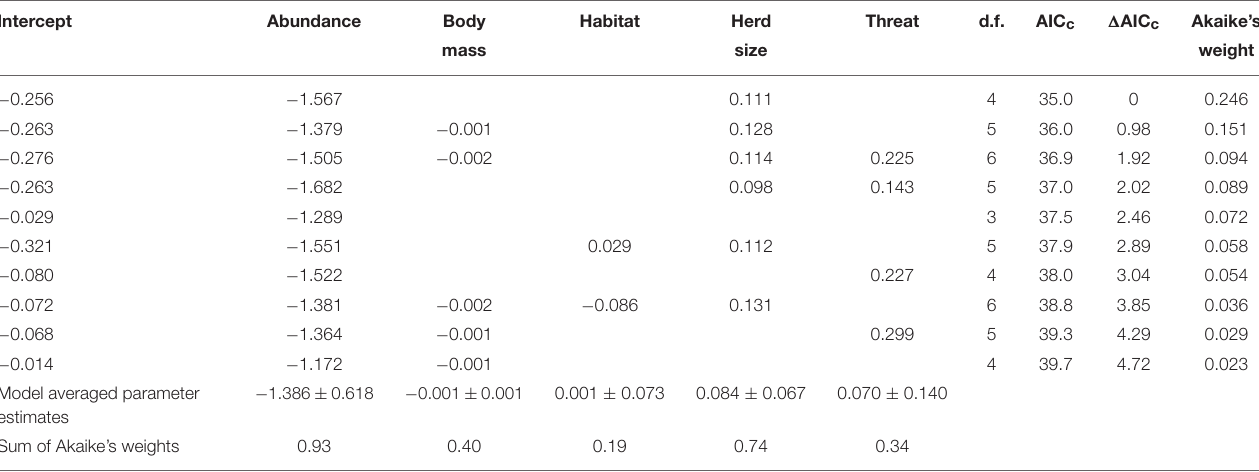
TABLE 3 | Model selection statistics for the 10 most supported models of drivers of jaguar prey selection, including model averaged parameter estimates and summed Akaike’s weights for each variable. Intercept